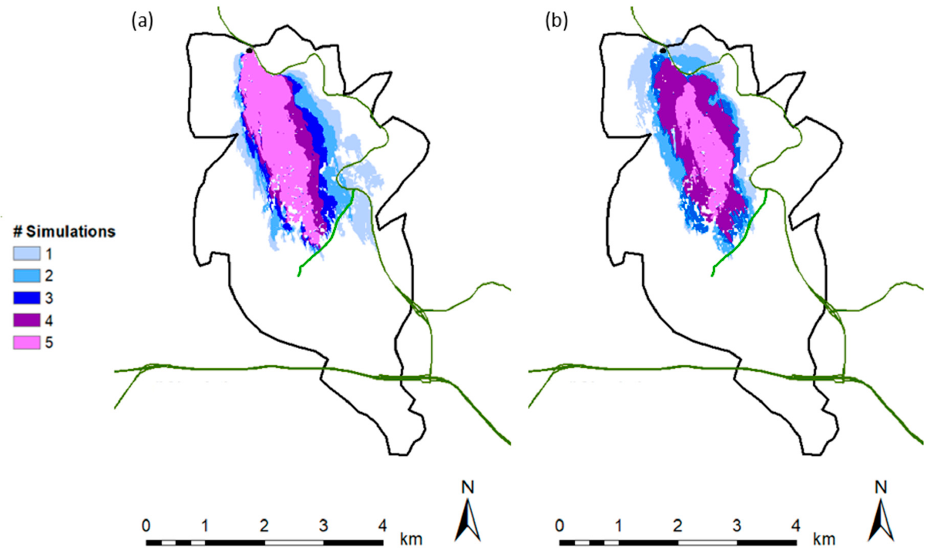
Figure A3. Painted Cave fire perimeter and reference roads (see Figure 7 for details). Colored polygons in ( a ) are the count of simulations four hours after ignition in the varied ignition time simulations. ( b ) The count of simulations four hours after ignition using varied ignition locations.